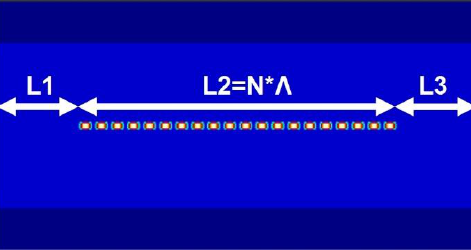
Figure 10. The x - z planar configuration of the optical fiber with FBG for numerical